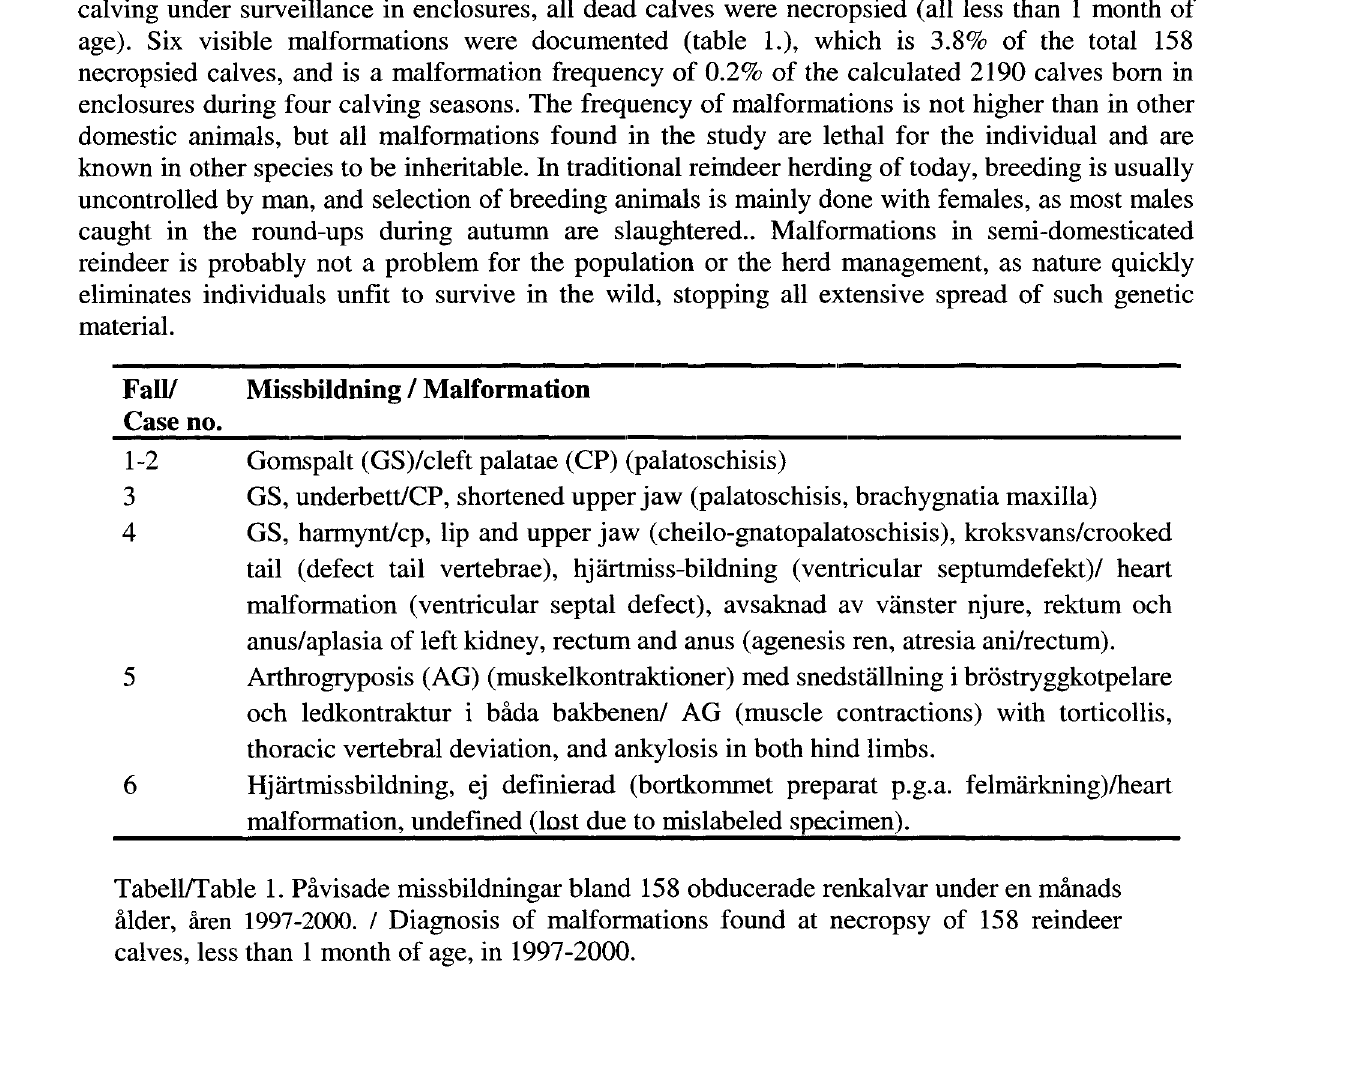
Tabell/Table 1. Påvisade missbildningar bland 158 obducerade renkalvar under en månads ålder, åren 1997-2000. / Diagnosis of malformations found at necropsy of 158 reindeer calves, less than 1 month of age, in